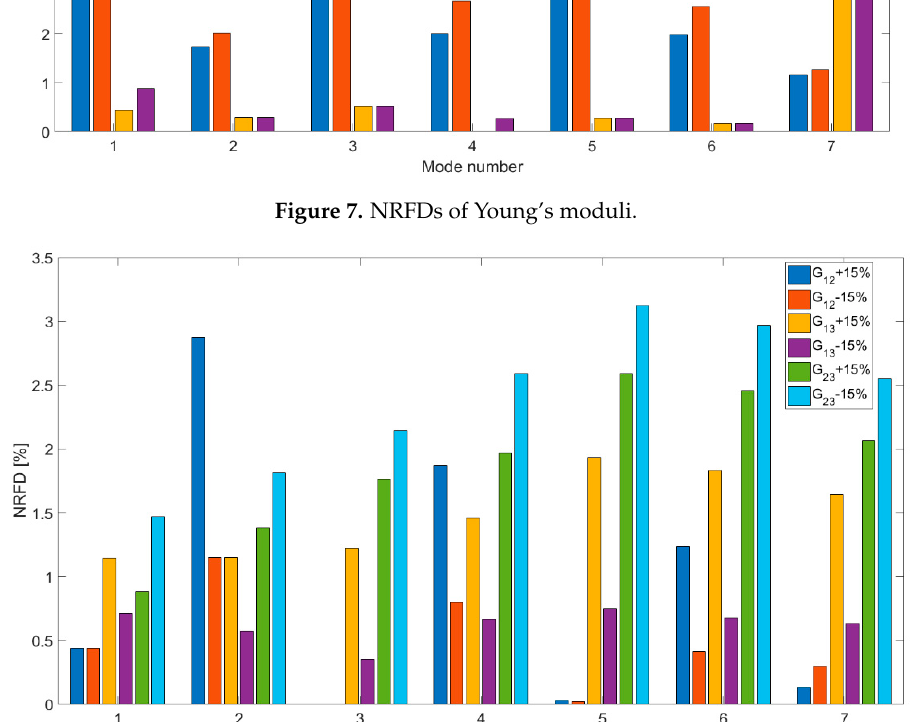
Figure 8. NRFDs of shear moduli.